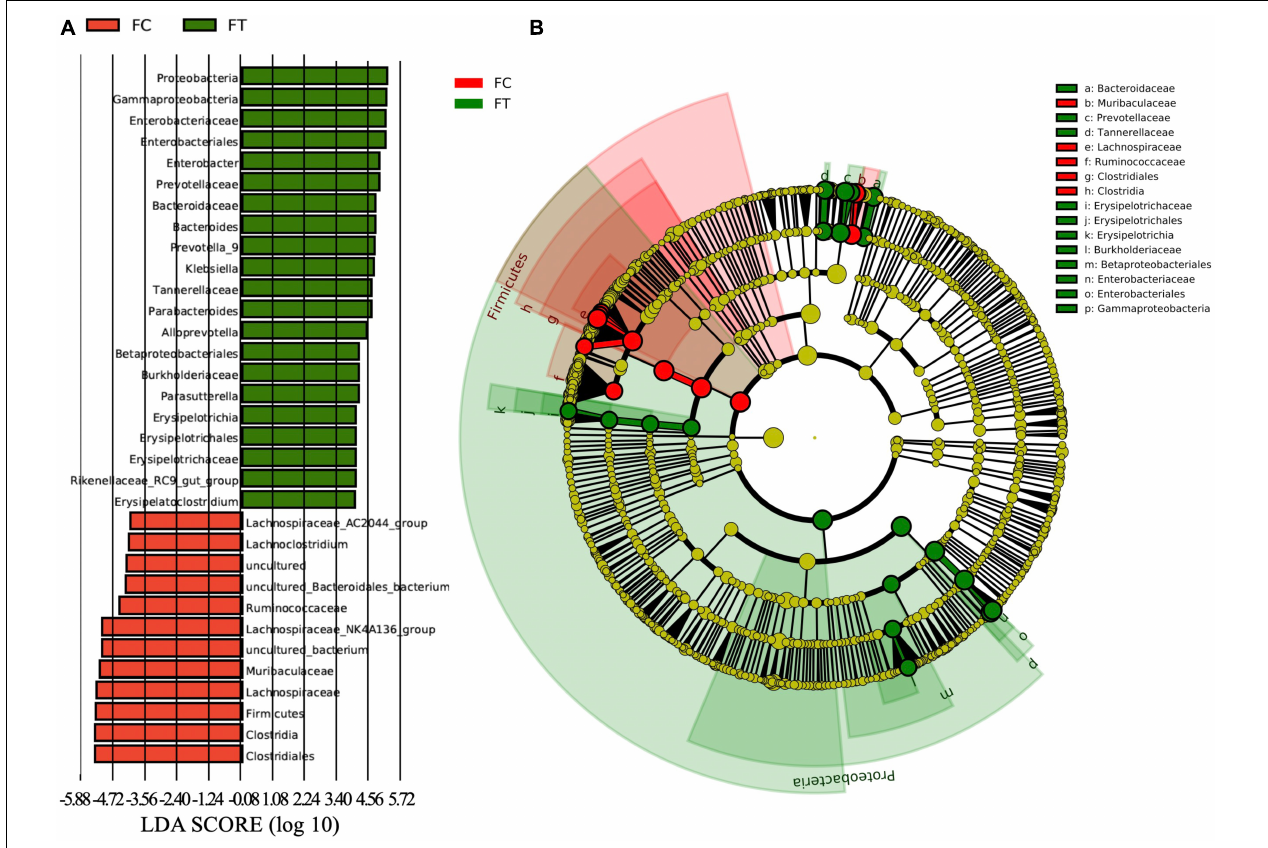
FIGURE 4 | The LDA (linear discriminant analysis) score (A) and the taxonomic cladogram (B) were obtained from linear discriminant analysis effect size (LEfSe) analysis of the gut microbiota of control females (FC) and the antibiotic-treated females (FT). Bar chart showing the log-transformed LDA scores of bacterial taxa identified by LEfSe analysis (the log-transformed LDA score of 6.0 as the threshold). Cladogram showing the phylogenetic relationships of bacterial taxa revealed by LEfSe. From inside to outside, the circle of radiation represented the classification level from phylum to genus. The red and green nodes in the phylogenetic tree represent gut microbiota that plays an important role in the FC and FT groups, respectively. While yellow nodes represent species showing no significant